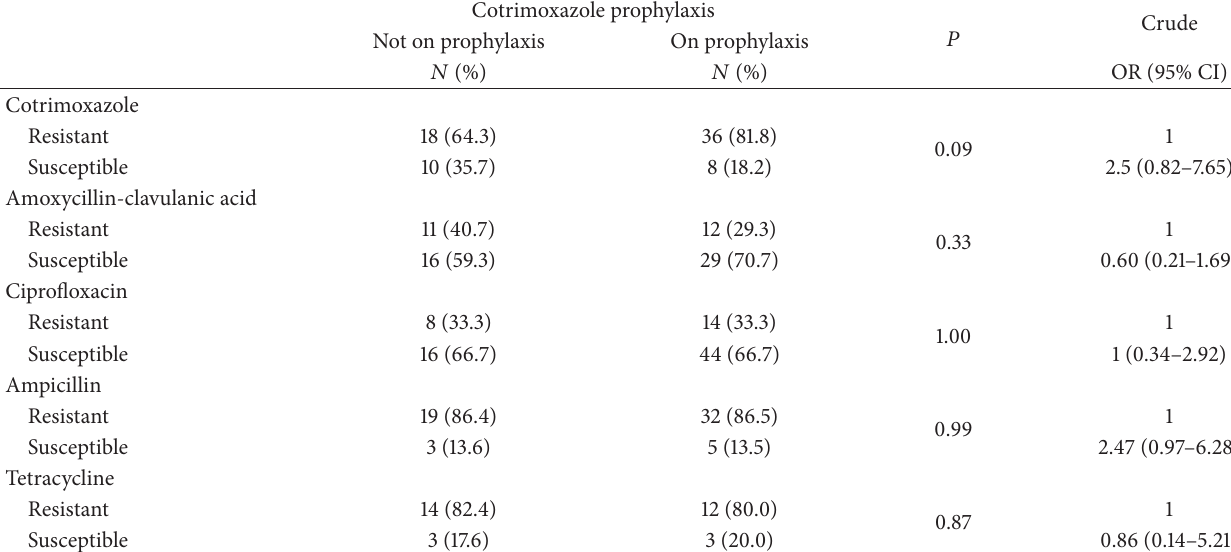
Table 4: Susceptibility data for isolates among HIV patients on prophylaxis and those not on